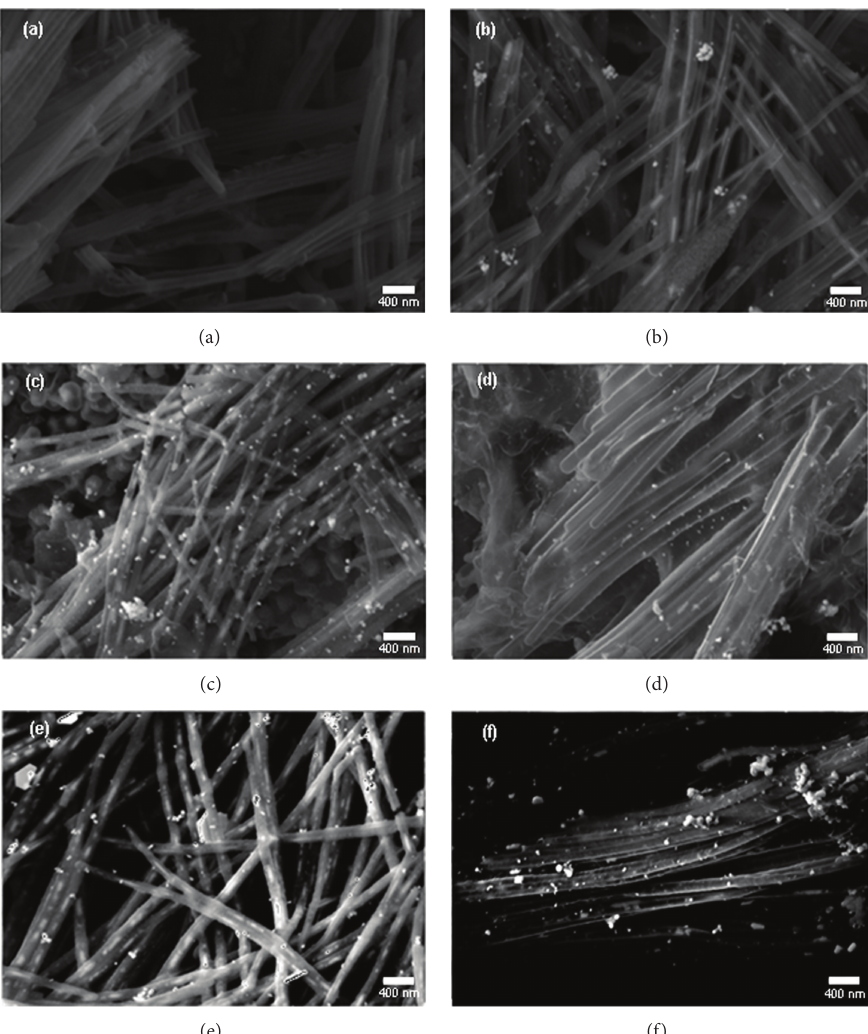
Figure 2: FESEM images of HNO 3 functionalized 𝛼 CNTN/Ag nanohybrids at different molars of AgNO 3 : (a) 0 M, (b) 0.01M, (c) 0.05 M, (d) 0.1M, (e) 0.5 M, and (f)